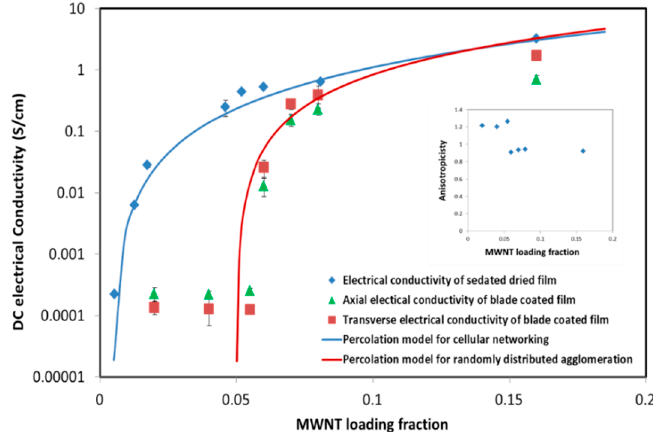
Figure 9. Electrical conductivity of sedated and blade sheared dried MWNT / CNC films as a function of MWNT volume fraction. The blade sheared film conductivity was measured in the direction of shear (axial) and perpendicular to shear (transverse). The inset is the anisotropicity (ratio of axial and transverse electrical conductivity) of blade-coated film conductivity at different MWNT loading fractions.